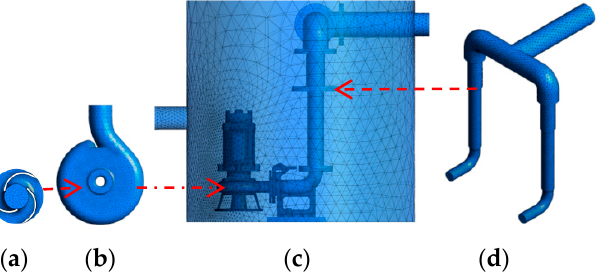
Figure 2. Grid diagram for each calculation area: ( a ) Impeller; ( b ) Volute Casing; ( c ) Centrifugal prefabricated pumping station; ( d ) Outlet section.